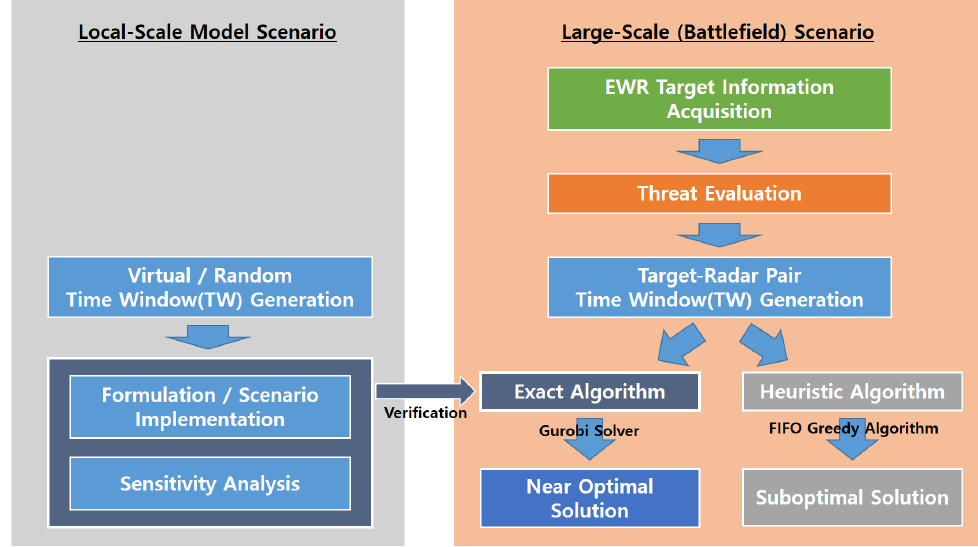
Figure 4. Overview of the numerical experiment.